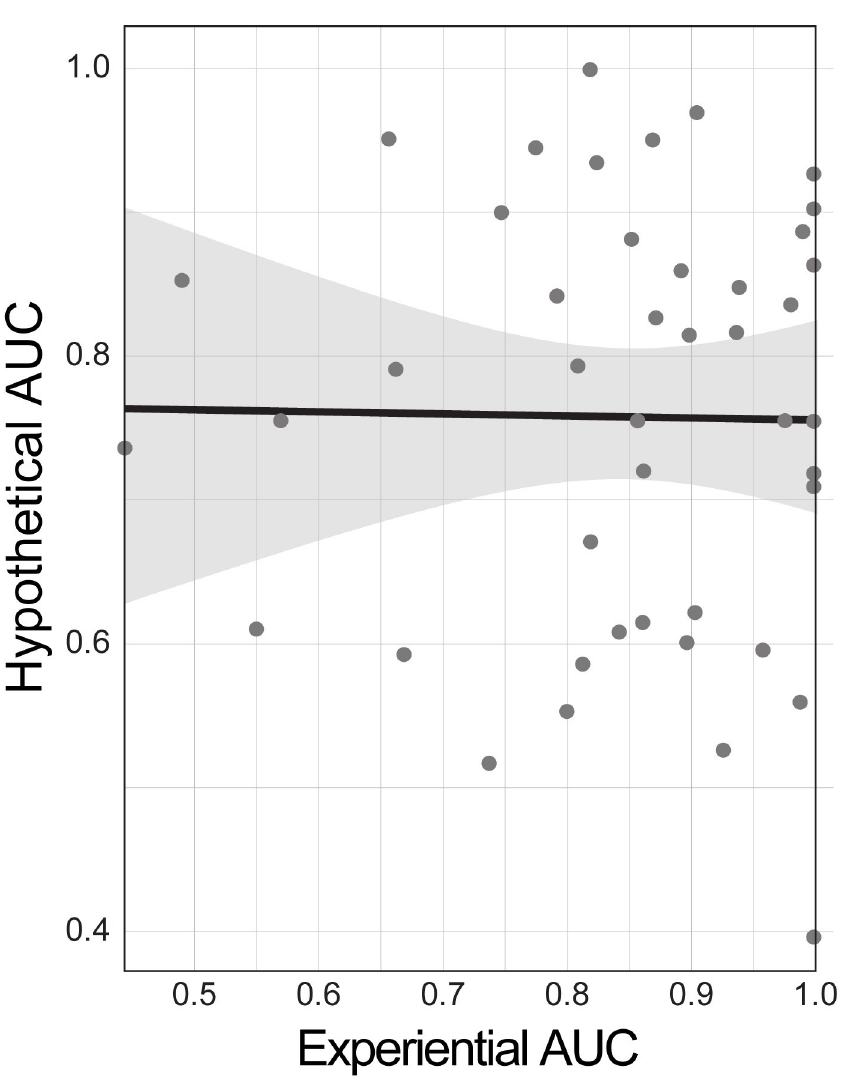
Fig 8. Absence of significant correlation between experiential AUC and hypothetical AUC . AUC stands for Area Under the Curve, with greater AUC implying greater willingness to wait for the delayed reward. experiential AUC and 5.9% of the variance in hypothetical AUC . Of note, the correlations of state anxiety with experiential AUC ( r = -0.05, p = .751) and trait anxiety with experiential AUC ( r = 0.28, p = .063) were not significant when considered in isolation. These results high- light the presence of an interaction between state and trait factors, which is accounted for by the path analysis. Linear regression on experiential AUC confirmed significance of a model including state anxiety, trait anxiety, and their interactions as regressors ( F(3 , 40) = 4.8, p = 0.006, R 2 = 0.26), with a significant state by trait anxiety interaction ( β = .0005, t = 2.5, p = 0.017). This interaction is illustrated in Fig 10 using a split-half method: individuals with lower trait anxiety generally displayed experiential AUC that decreased (less willingness to wait) with increasing state anxiety ( r = -0.41, p = .057); while individuals with higher trait anxi- ety displayed experiential AUC that remained high, independent of their state anxiety ( r = 0.04, p = .850).